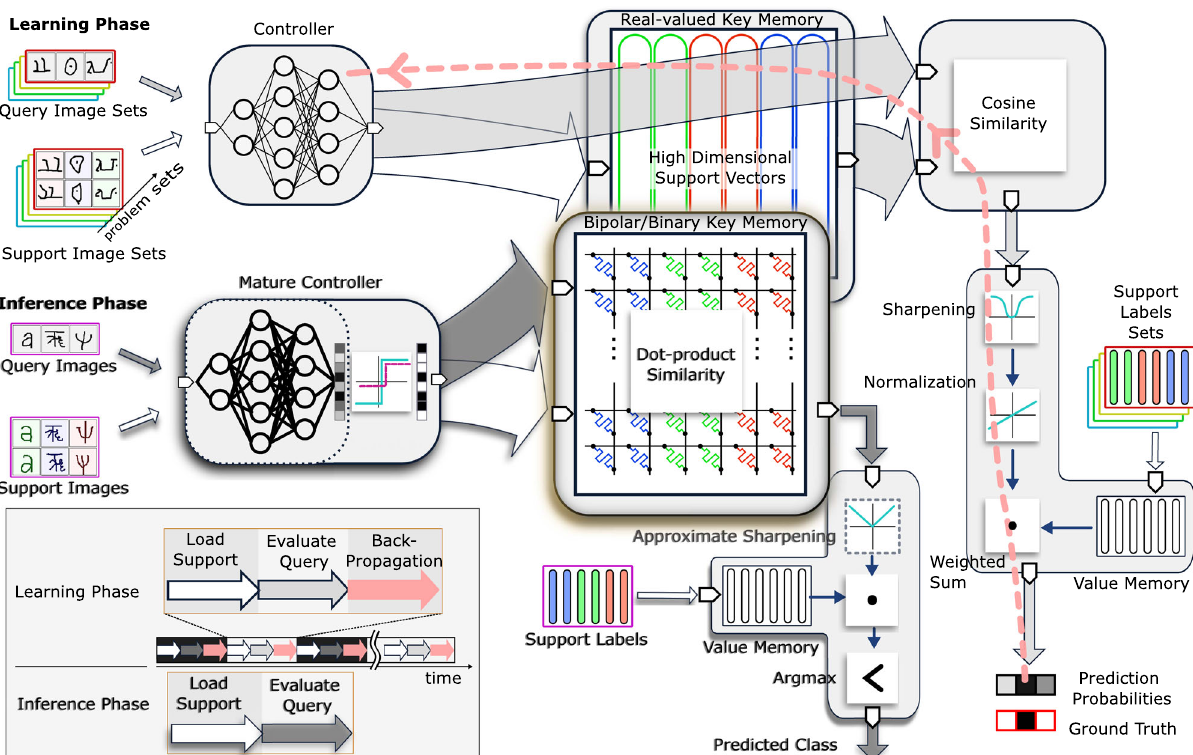
Fig. 2 Proposed robust HD MANN architecture. The learning phase of the proposed MANN involves a CNN controller which fi rst propagates images in the support set to generate the HD support vector representations that are stored in the real-valued key memory. The corresponding support labels are stored in the value memory. For the evaluation, the controller propagates the query images to produce the HD vectors for the query. A cosine similarity module then compares the query vector with each of the support vectors stored in the real-valued key memory. Subsequently, the resulting similarity scores are subject to a sharpening function, normalization, and weighted sum operations with the value memory to produce prediction probabilities. The prediction probabilities are compared against the ground truth labels to generate an error which is backpropagated through the network to update the w eights of the controller (see pink arrows). This episodic training process is repeated across batches of support and query images from different problem sets until the controller reaches maturity. In the inference phase, we use a hardware-friendly version of our architecture by simplifying HD vector representations, similarity, normalization, and sharpening functions. The mature controller is employed along with an activation function that readily clips the real-valued vectors to obtain bipolar/binary vectors at the output of controller. The modi fi ed bipolar or binary support vectors are stored in the key memristive crossbar array (i.e., bipolar/binary key memory). Similarly, when the query image is fed through the mature controller, its HD bipolar or binary representation, as a query vector, is used to obtain similarity scores against the stored support vectors in the memristive crossbar array. The bipolar/binary key memristive crossbar approximates cosine similarities between a query and all the support vectors with the constant-scaled dot products in O ð 1 Þ by employing in-memory computing. The results are weighted and summed by the support labels (in the value memory) after an approximate sharpening step and the maximum response index is output as the